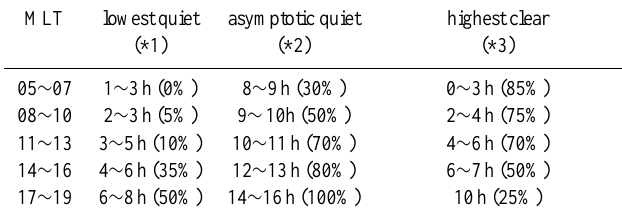
Table 1. Characteristic times (hours) and probability